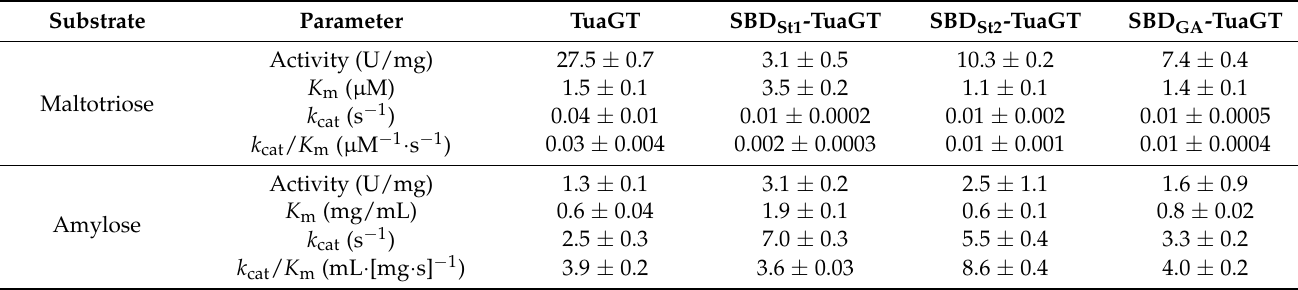
Table 2. Activity and kinetic parameters of Tu α GT and SBD-Tu α GT fusions towards maltotriose and amylose at 70 ◦ C and pH